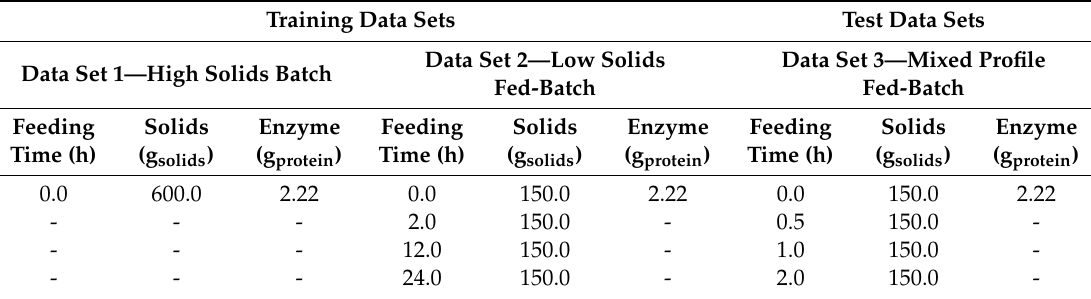
Table 1. Data Sets Feeding